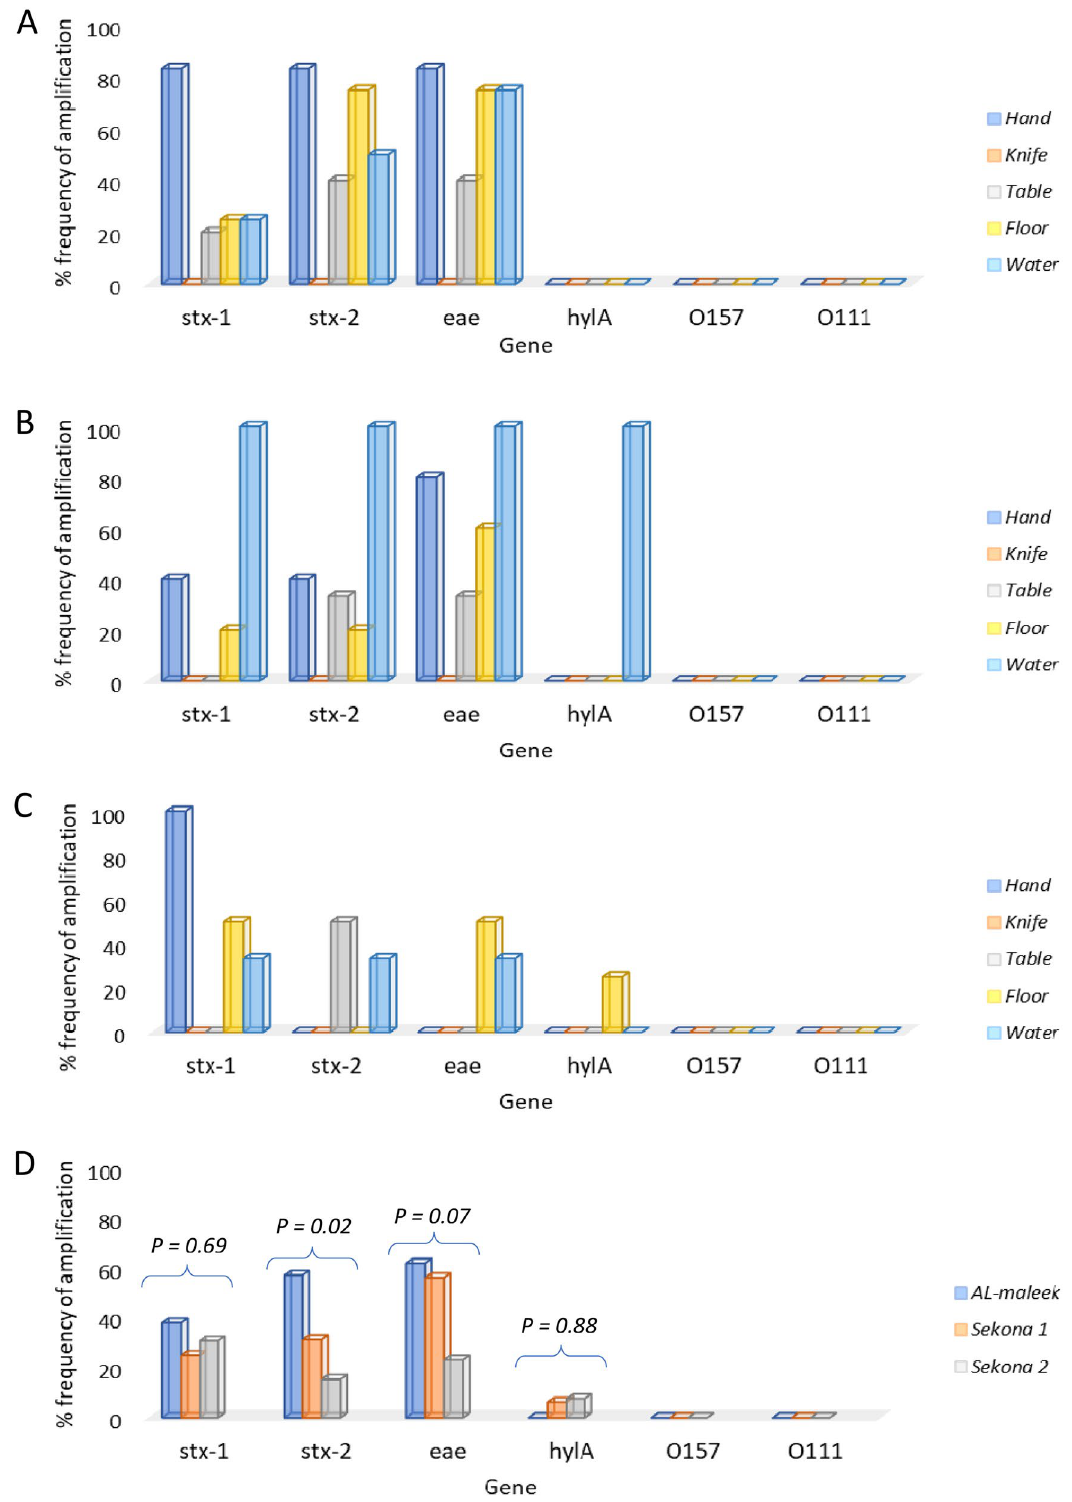
Figure 2. Distribution of stx-1, stx-2, eae, hylA, O157 and O111 genes among E. coli isolates from Al-maleek ( A ), Sekona-1 ( B ), Sekona-2 and in all three sites ( D ) pooled